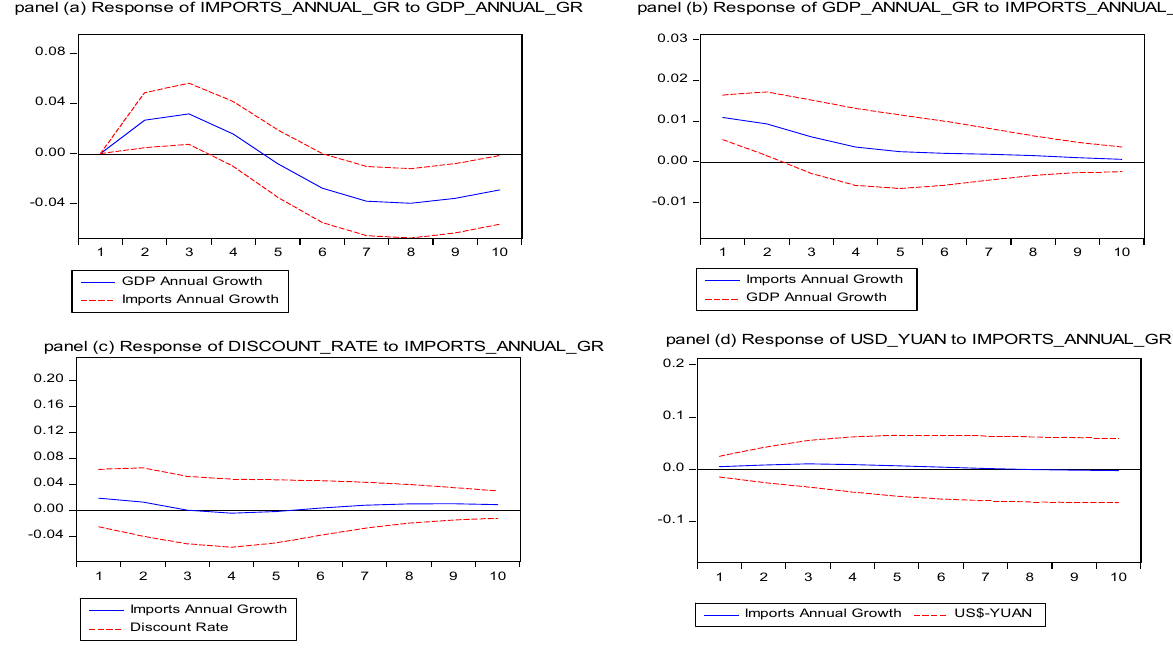
Figure 2. VAR model, impulse responses. Source: Author’s calculations; data retrieved from https://fred.stlouisfed.org/series, accessed on 7 June 2021. https://fred.stlouisfed.org/series, accessed on 7 June